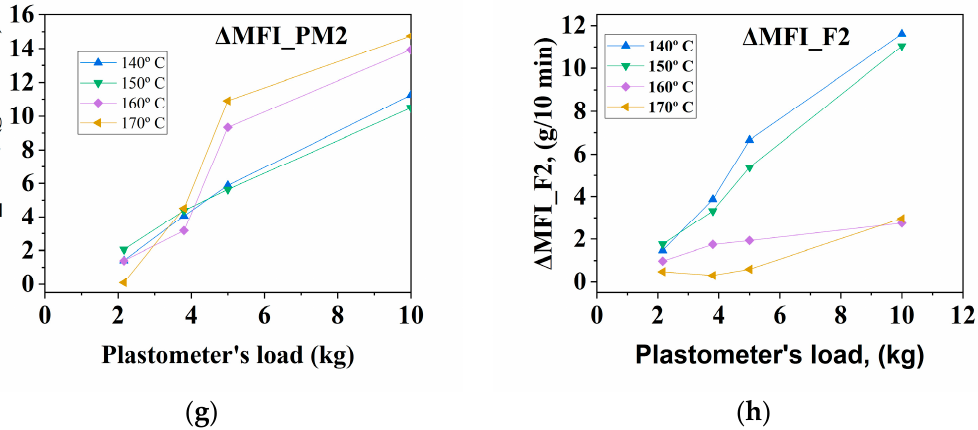
Figure 2. The melt rheological properties of the recycled PM2 compound ( a – d ) with those of the primary F2 ( e – h ) and their dependence on the flowing conditions (for PM2: ( a ) MFI = f(T); ( b ) Δ MFI = f(T); ( c ) MFI = f(G); ( d ) Δ MFI = f(G)); (for F2 : ( e ) MFI = f(T); ( f ) Δ MFI = f(T); ( g ) MFI = f(G); ( h ) Δ MFI = f(G)).